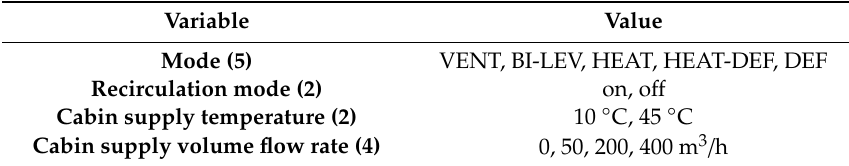
Table 7. Parametric variation of the CFD